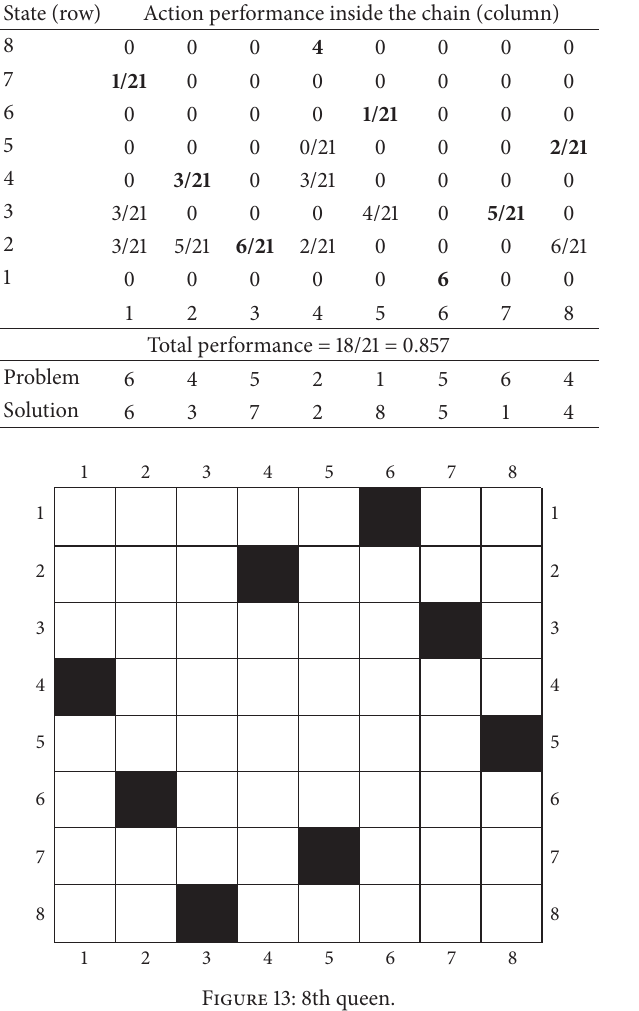
Figure 13: 8th queen.